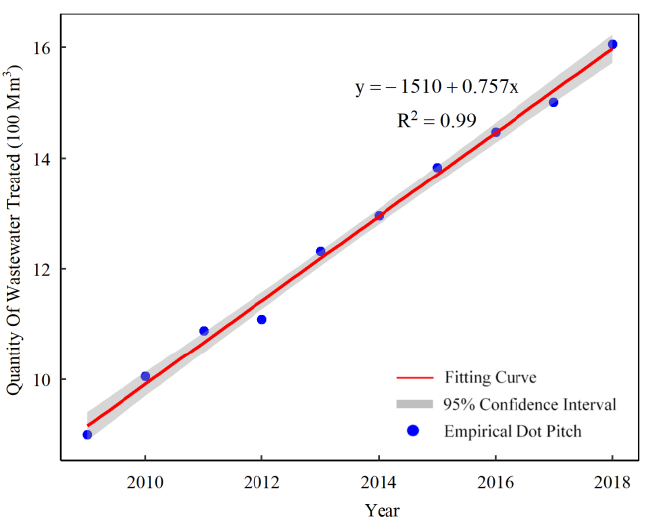
Figure 6. Investment in drainage fixed assets.